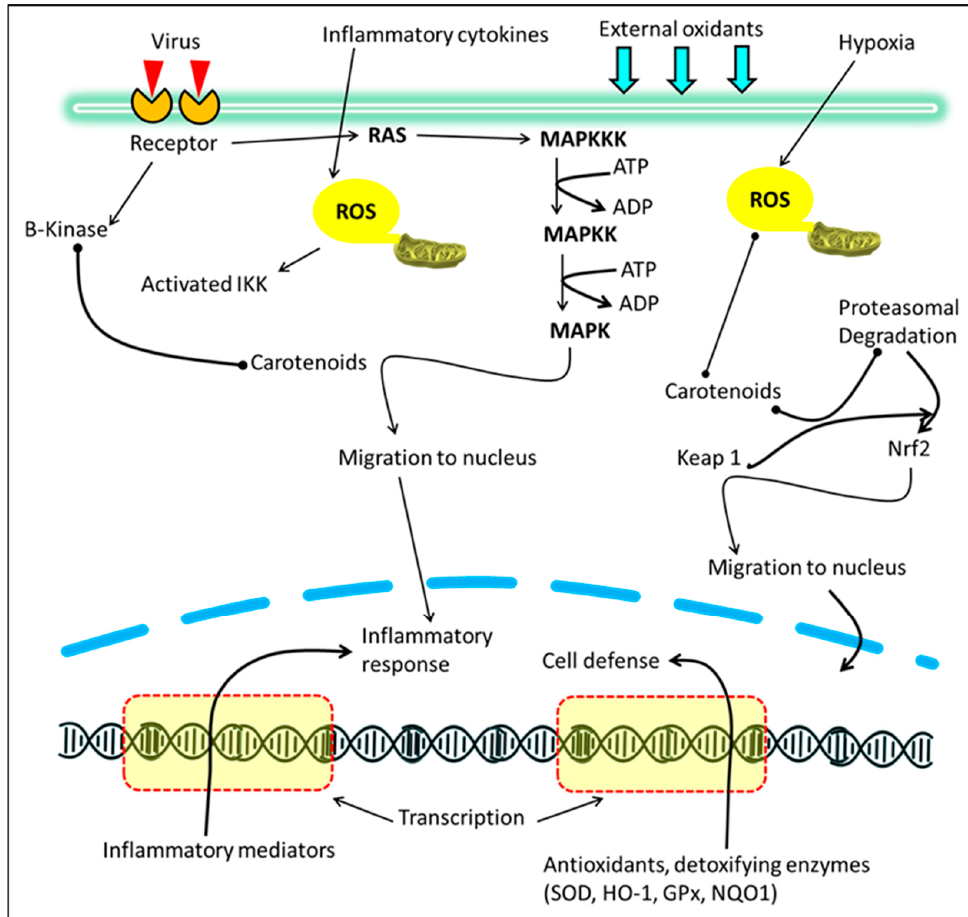
Figure 4. Carotenoids and the signaling pathways involved in inflammation. MAPK, mitogen-activated protein kinase; ROS, reactive oxygen species; Nrf2, nuclear factor erythroid 2–related factor 2; SOD, superoxide dismutase, RAS, rat sarcoma.